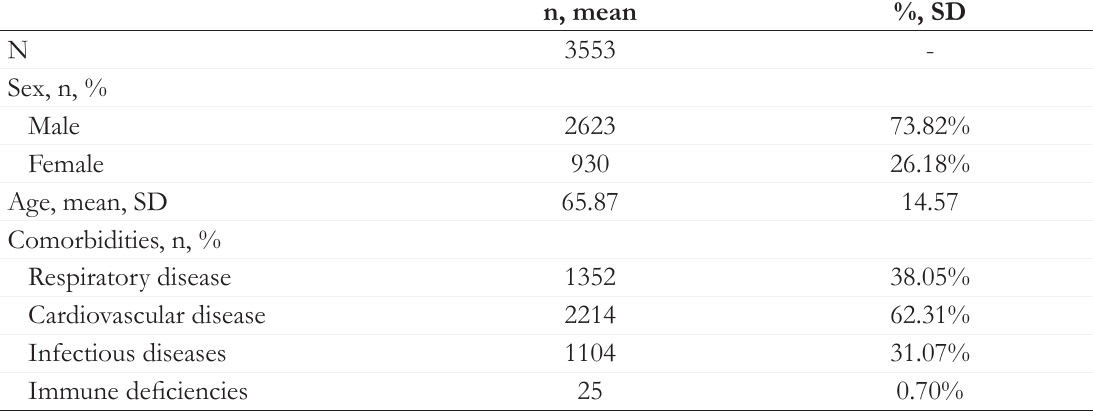
Table 5. Characteristics of Patients Included in the MDV Data